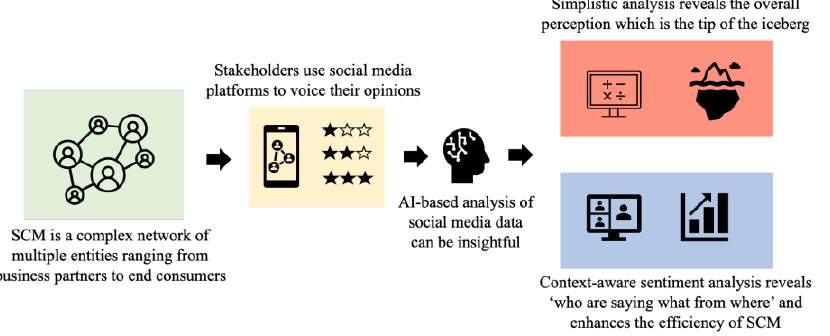
Figure 1. Application of context-aware sentiment analysis for SCM.